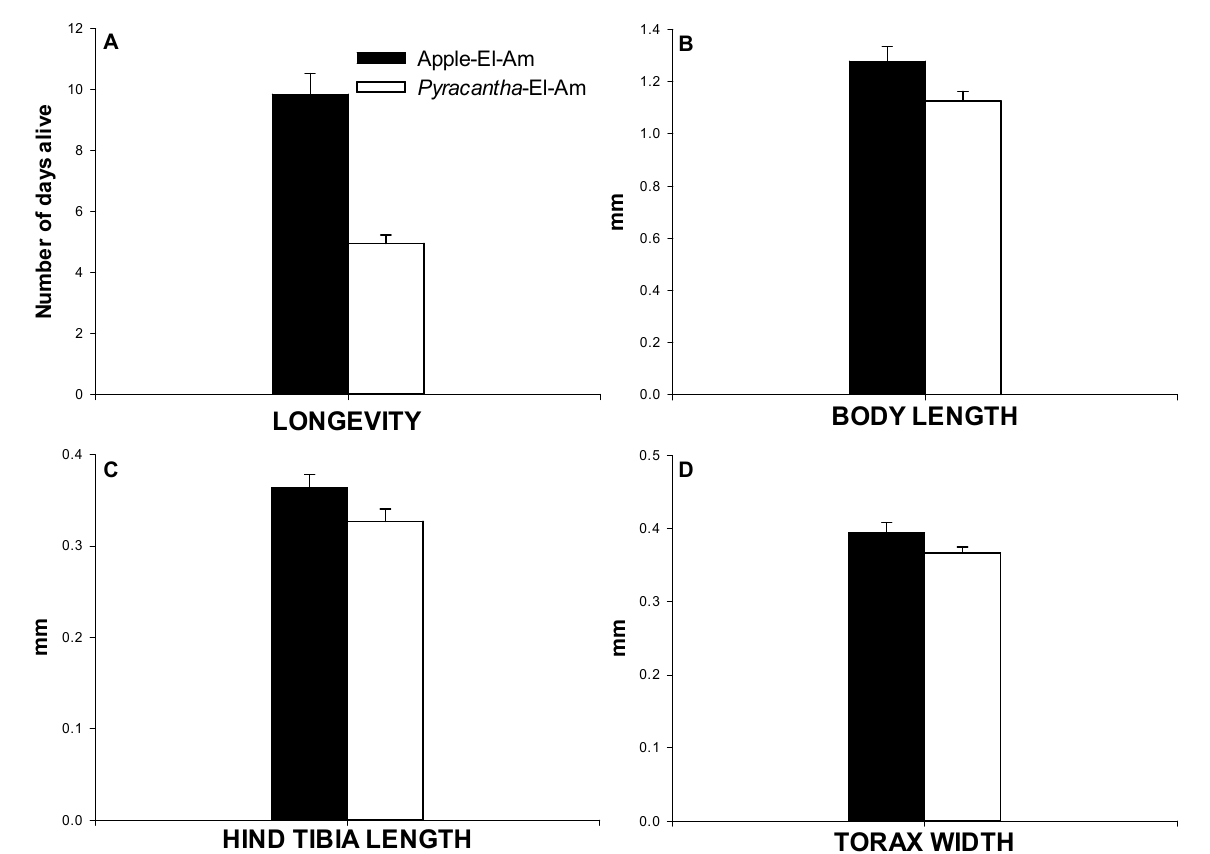
Figure 2. Longevity ( A ) and measurements of different morphological features (body length: ( B ); hind tibia length: ( C ); thorax width: ( D ) of A. mali from two aphid origins (apple trees (black bars) and Pyracantha coccinea (white bars)). Table 1. Mean number ± SE of the occurrence, duration and duration per event of the stinging, attacking and feeding events of Aphelinus mali females emerging from aphids feeding on apple trees (Apple-El-Am) or on P. coccinea plants ( Pyracantha -El-Am). Also, the proportion of time of A. mali spent at the base of the arena and moving on the base or on the walls of the arena. HPC Stinging Attacking Feeding